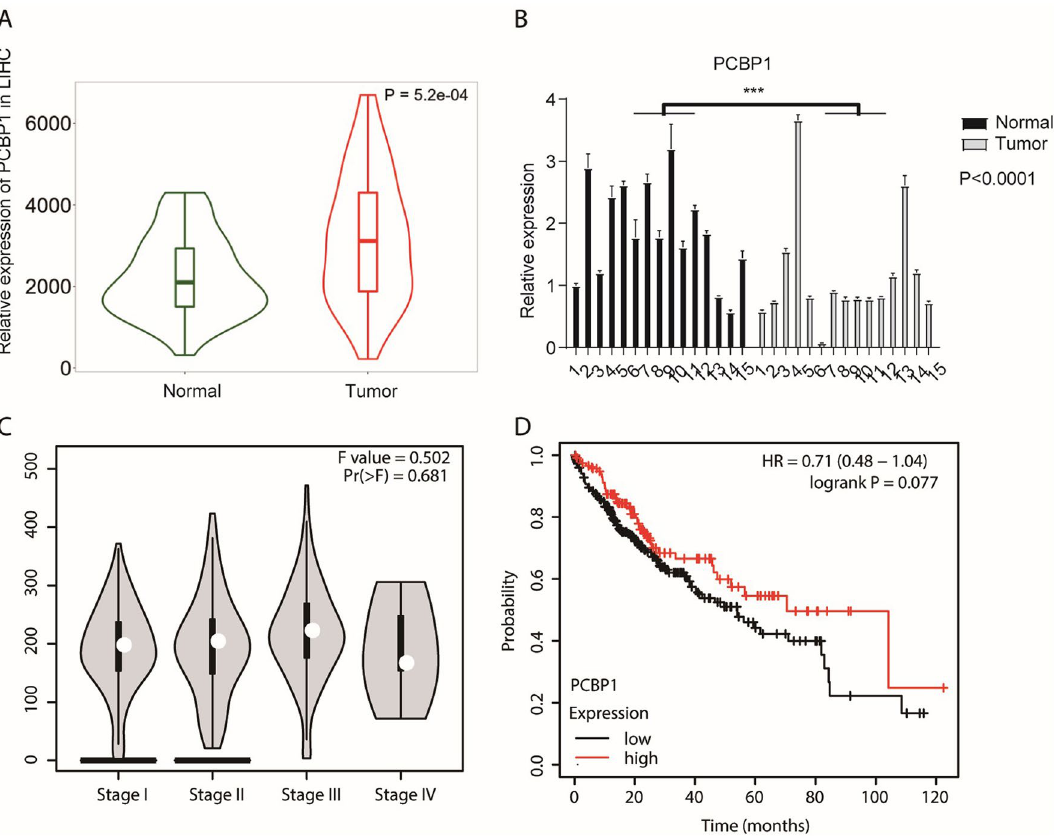
Figure 5. The expression level of PCBP1 in HCC tissues was lower than that in normal tissues, and the survival time of patients with low expression of PCBP1 was lower. ( A ) Based on liver hepatocellular carcinoma (HCC) data in TCGA database, the expression level of PCBP1 in HCC tissues was higher than that in normal tissues. ( B ) Quantitative experiments were carried out in 15 cases of HCC and 15 cases of normal liver tissues. The results showed that the expression level of PCBP1 in HCC tissues were lower than that in normal tissues, that is, the expression level of PCBP1 was downregulated. ( C ) Based on the data of HCC in TCGA database, the expression level of PCBP1 in different stages of HCC was analyzed. ( D ) Prognostic analysis of PCBP1 was performed using the kmplot online tool, and the results showed that the survival time of patients with low expression of PCBP1 was lower. PCBP1, Poly C Binding Protein 1; HCC, hepatocellular carcinoma; TCGA, the cancer genome atlas SPHK1 genes ( P = 0.0391) (Fig. 4E and F). In summary, our experiments confirmed that our findings on PCBP1- regulated gene expression and ASEs are convincing. PCBP1 expression is different in HCC and normal tissues and is associated with clinical fea‑ tures of HCC. To verify the reliability of the PCBP1 gene expression difference between the experimental groups and the control groups retrieved from the ENCODE database in this study, we searched The Cancer Genome Atlas (TCGA) database and drew a PCBP1 expression level distribution map based on the HCC data from the TCGA database. We found that the expression level of PCBP1 in tumour tissues was higher than that in adjacent tissues ( P = 5.2e−04) (Fig. 5A). To confirm the expression level difference of the PCBP1 gene between cancer tissues and normal tissues, q-PCR was conducted, and the results showed that PCBP1 gene expression in 15 patients with HCC was decreased compared with that in 15 samples of cancer tissue ( P < 0.0001). Two-way ANOVA was performed to confirm the significant difference between the two groups. However, the results of RT-qPCR experiments conducted on 15 samples of HCC and 15 samples of normal liver tissues were contrary to the above conclusions (Fig. 5B). The experimental results showed that the expression level of PCBP1 in HCC tissues was lower than that in normal tissues ( P < 0.0001). Previous studies have shown that RBPs are signifi- cantly related to the clinical stage and prognosis of tumours. This difference might be due to the different clinical stages of HCC. Tumour diameter and degree of differentiation may also cause this phenomenon. Based on the HCC data in the TCGA database, we showed the expression level of PCBP1 in different stages of HCC (Fig. 5C). To further investigate the correlation between PCBP1 and clinical forecasting in HCC patients, we evaluated the prognostic implications of PCBP1 using the TCGA database (http:// www. oncol nc. org/). We used the “Auto select best cutoff” option for automatic calculation, and the final expression cutoff used is 15,686. The p value does not reach the general threshold of 0.05, but it is still significant from the graph. We speculated that patients